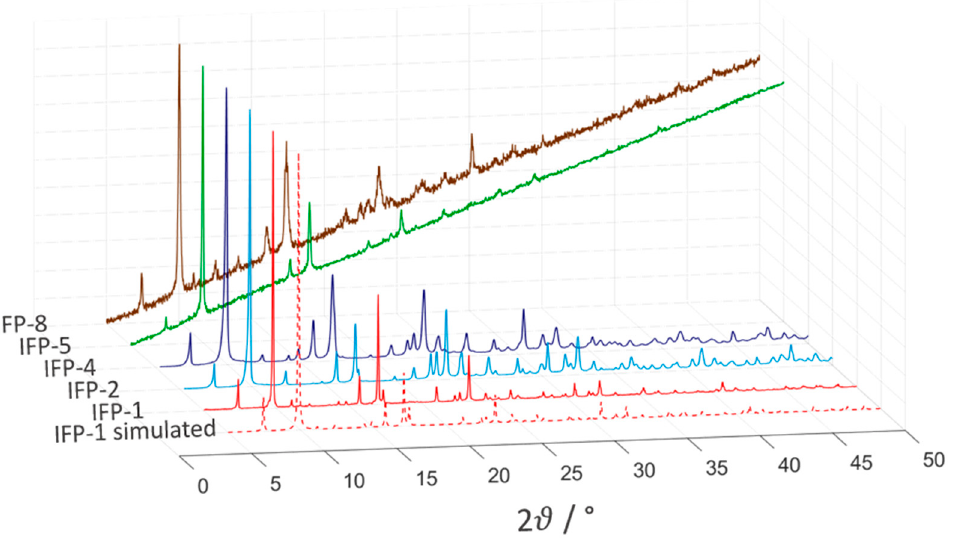
Figure 4. Normalized powder X-ray diffractograms of all the considered IFPs (as synthesized).